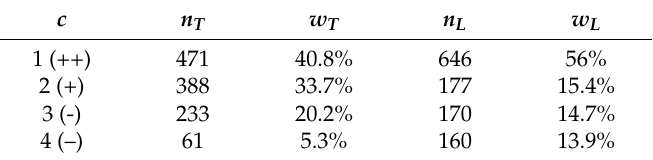
Table 1. Probability of occurrence in the considered four classes of significance c . The example refers to Asia, with n TOT = 1153. Number and percentage of stations in Asia with significance increasing ( c = 1, ++), non-significance increasing ( c = 2, +), non-significance decreasing ( c = 3, -), and significance decreasing trends ( c = 4, –) based on observed p T and p L